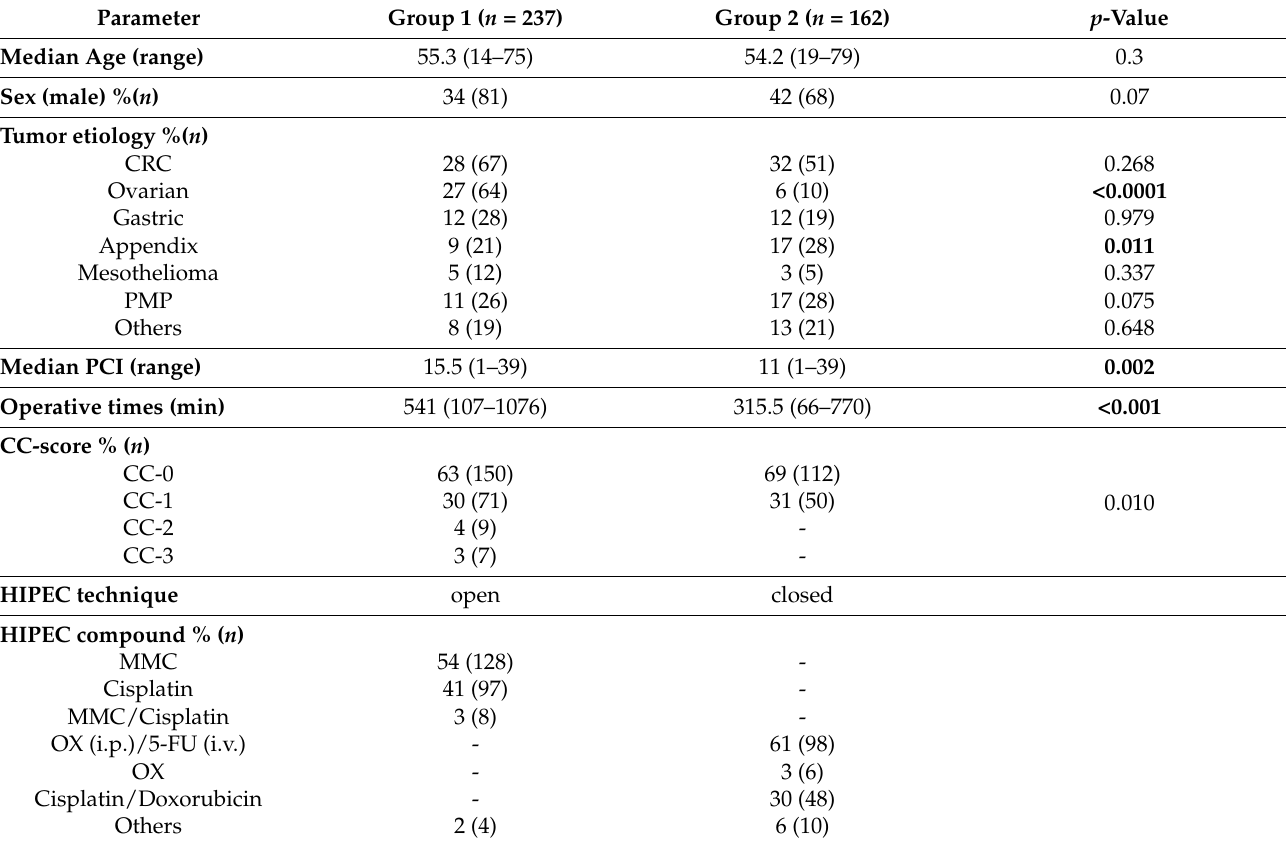
Table 1. Patient- and treatment-related parameters (5-FU = 5-Fluorouracil; CC = completeness of cytoreduction; CRC = colorectal cancer; i.p. = intraperitoneal; i.v. = intravenous; min = minutes; MMC = mitomycin C; OX =